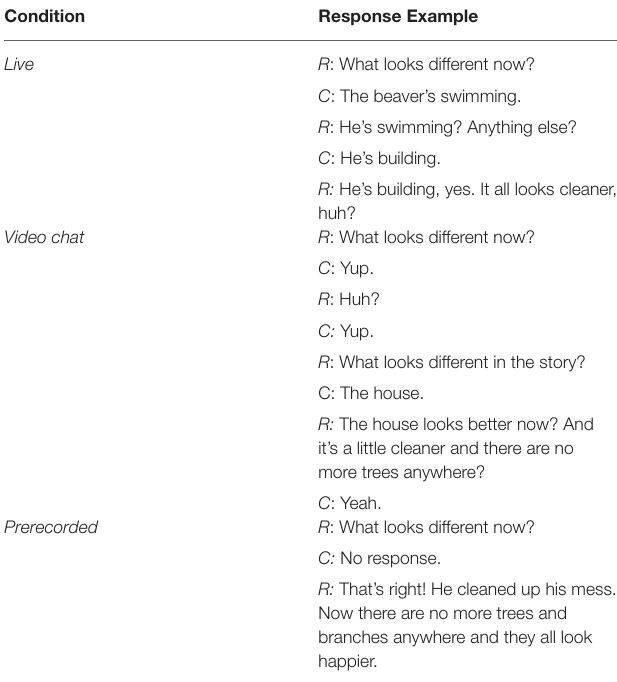
TABLE 4 | Examples of reader’s feedback to children during